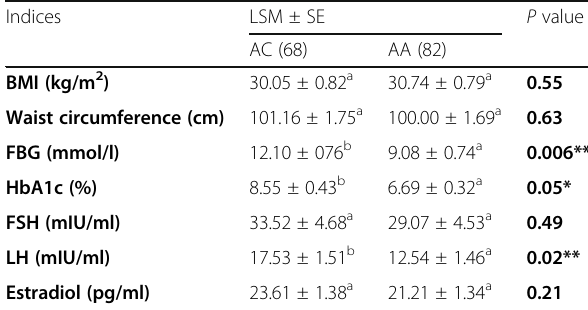
Table 8 Effect of BMP15 genotypes on some physiological parameters of type 2 diabetic and control